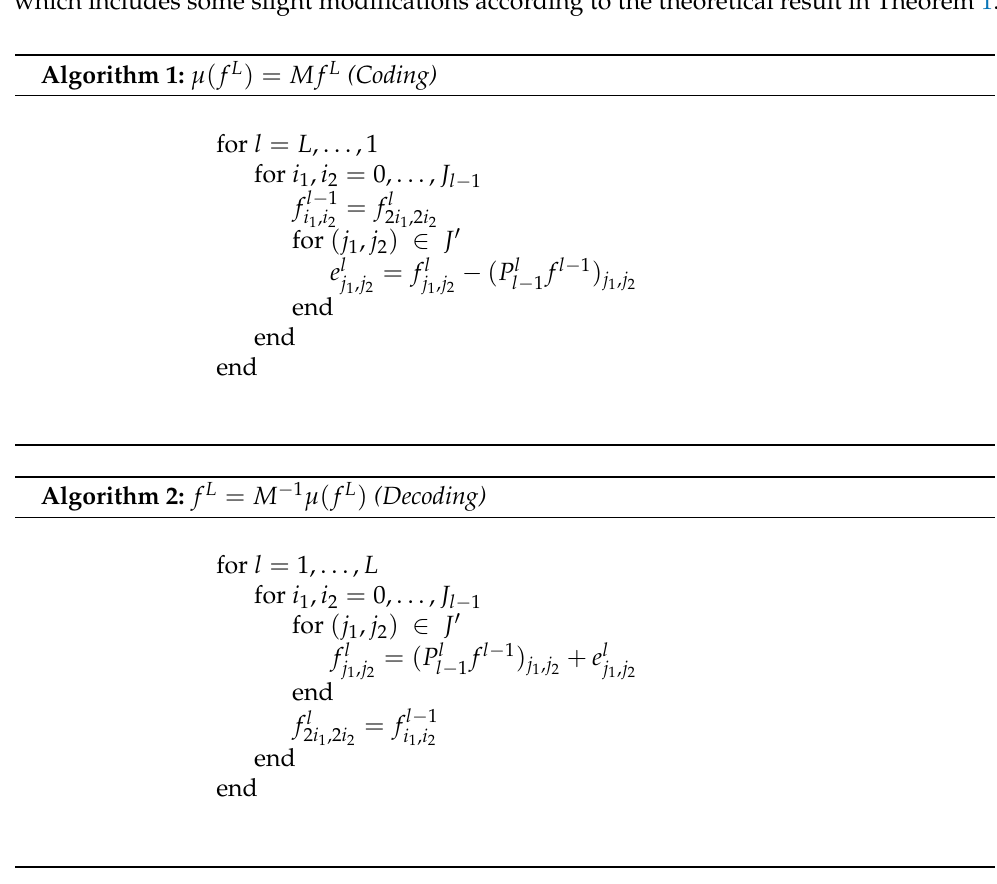
Algorithm 2: f L = M − 1 µ ( f L ) (Decoding)